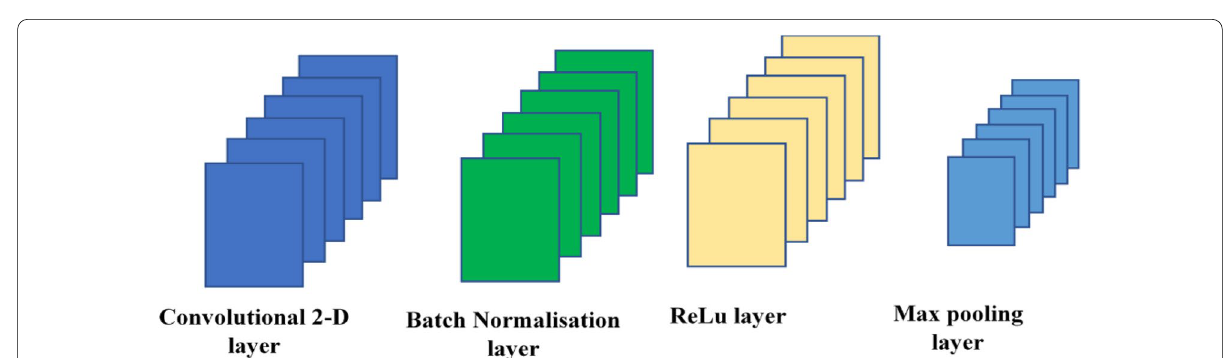
Figure 6 Layers of each feature learning block of the CNN in Figure 5